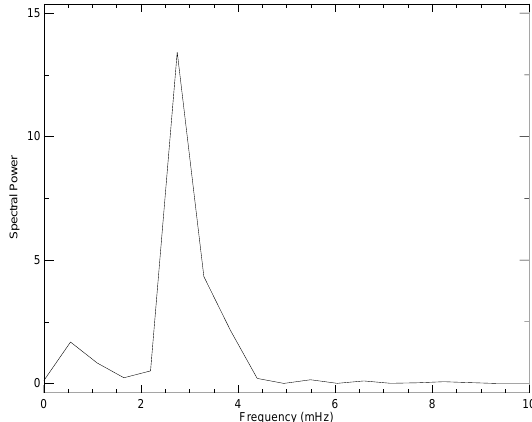
Fig. 18. Power spectrum from STARE Norway beam 2, range gate 38, between 01:30UT and 02:00UT.